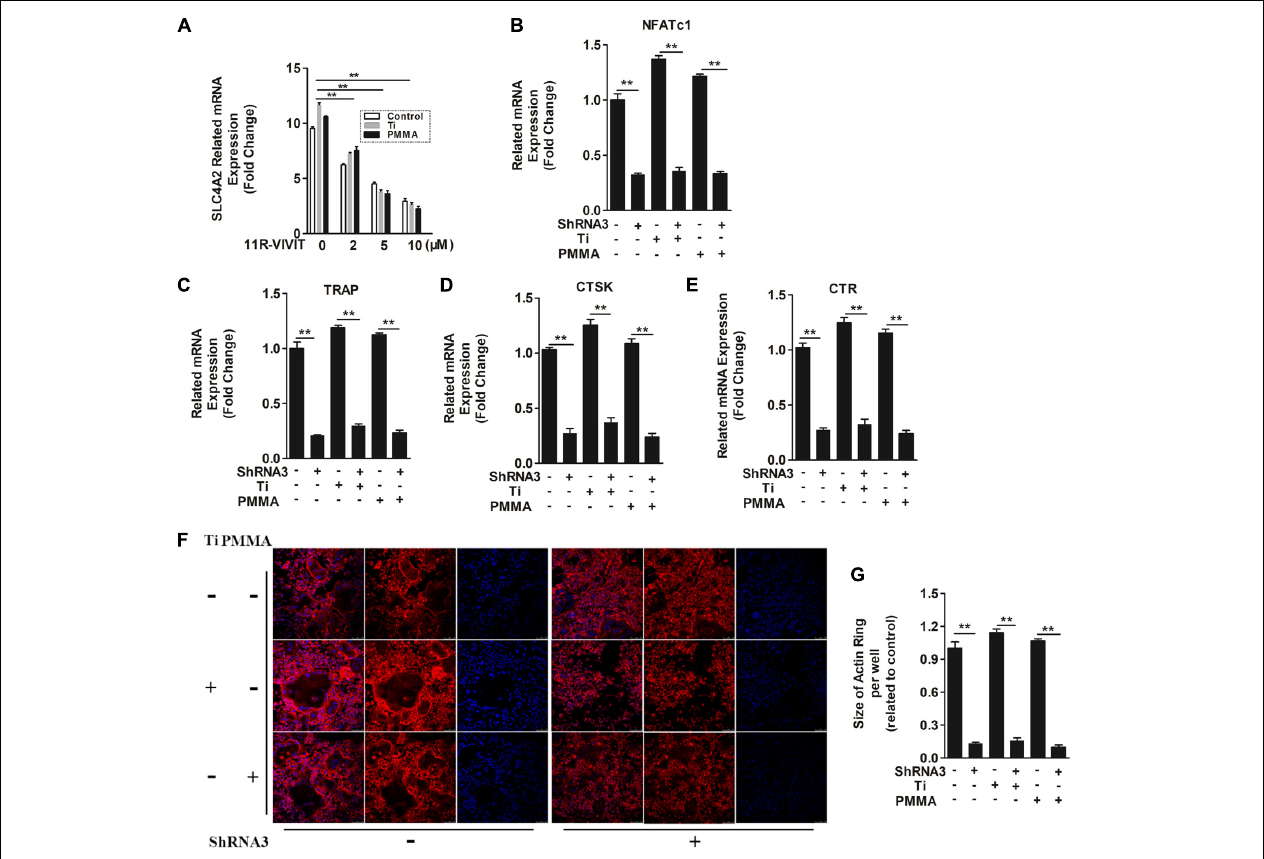
FIGURE 3 | The mechanism of SLC4A2 in wear particle-induced osteoclast differentiation and function. (A) 11R-VIVIT, an inhibitor of NFATc1 suppressed up-regulation of Slc4a2 expression during wear particle-induced osteoclastogenesis. (B) Expression of Nfatc1 was inhibited by knockdown of Slc4a2 with shRNA3 unexpectedly. (C–E) Suppression of osteoclast-specific gene expression ( Trap , Ctsk , Ctr ) with knockdown of Slc4a2 with shRNA3. (F) Knockdown of Slc4a2 , using shRNA3, inhibits F-actin ring formation in vitro . (G) The size of F-actin rings, measured using ImageJ ( ∗ P < 0.05; ∗∗ P < 0.01). At least three independent replicated of each experiment were conducted